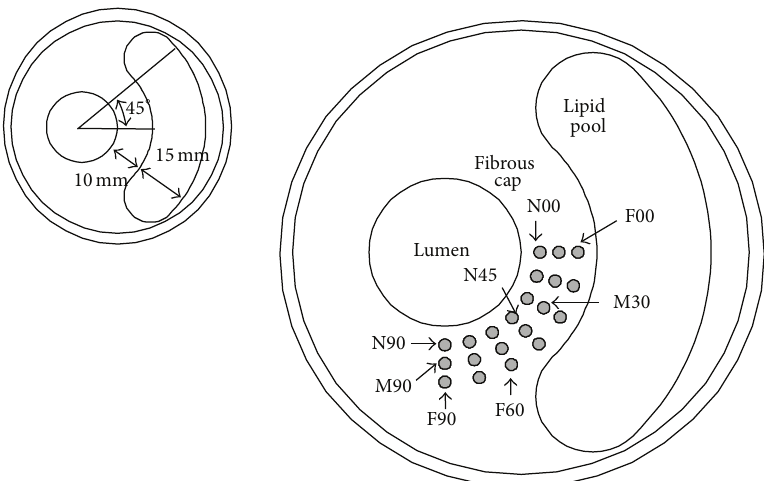
Figure 1: Different calcification cases. Here the capitals N, M, and F, respectively, mean a near, middle, and far distance from the lumen; and the number after the letter means the angle from the 𝑥